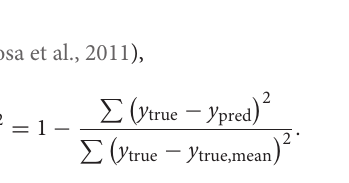
variance (Pedregosa et al.,